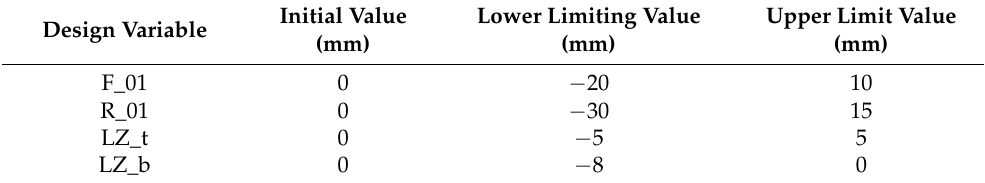
Figure 7. Parameterized model and optimized position of aluminium alloy front subframe. Table 3. Variation range of design variables of aluminium alloy front